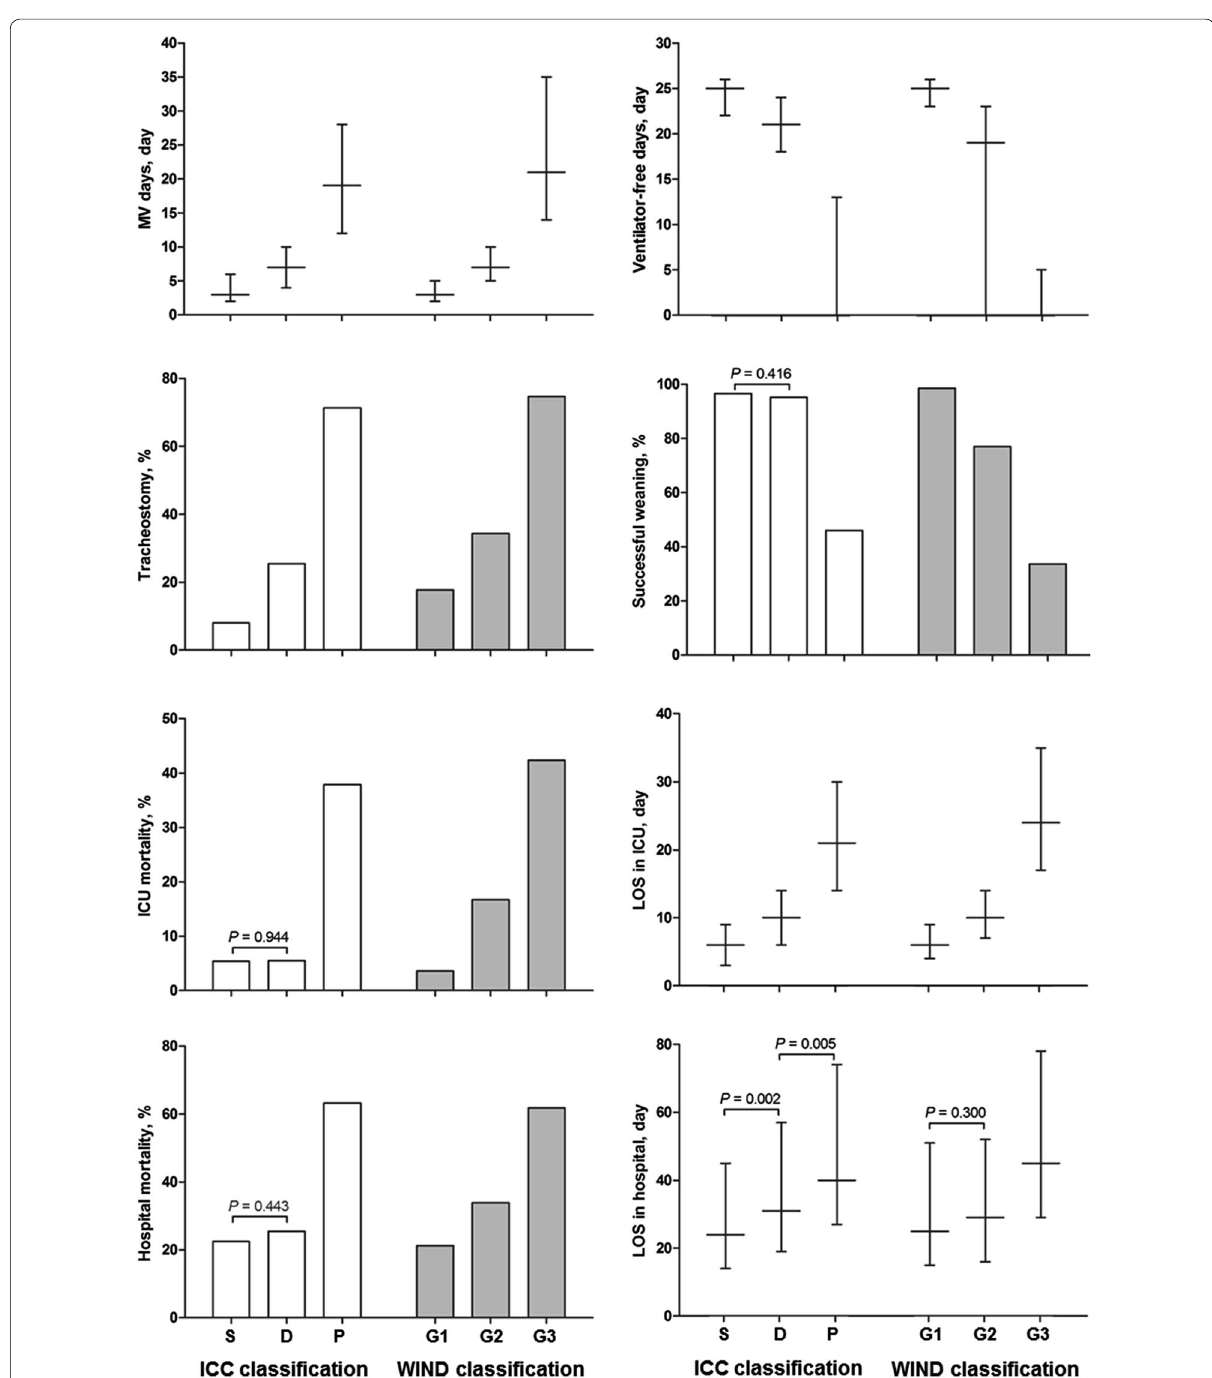
Fig. 2 Comparisons of weaning outcomes between groups according to ICC and WIND classifications. Data are presented as medians and interquartile ranges for continuous variables and as percentages for categorical variables. P values between groups are < 0.001 except where otherwise noted. ICC International Consensus Conference, WIND Weaning according to a New Definition, MV mechanical ventilation, ICU intensive care unit, LOS length of stay, G1 Group 1, G2 Group 2, G3 Group 3, S simple weaning group, D difficult weaning group, P prolonged weaning